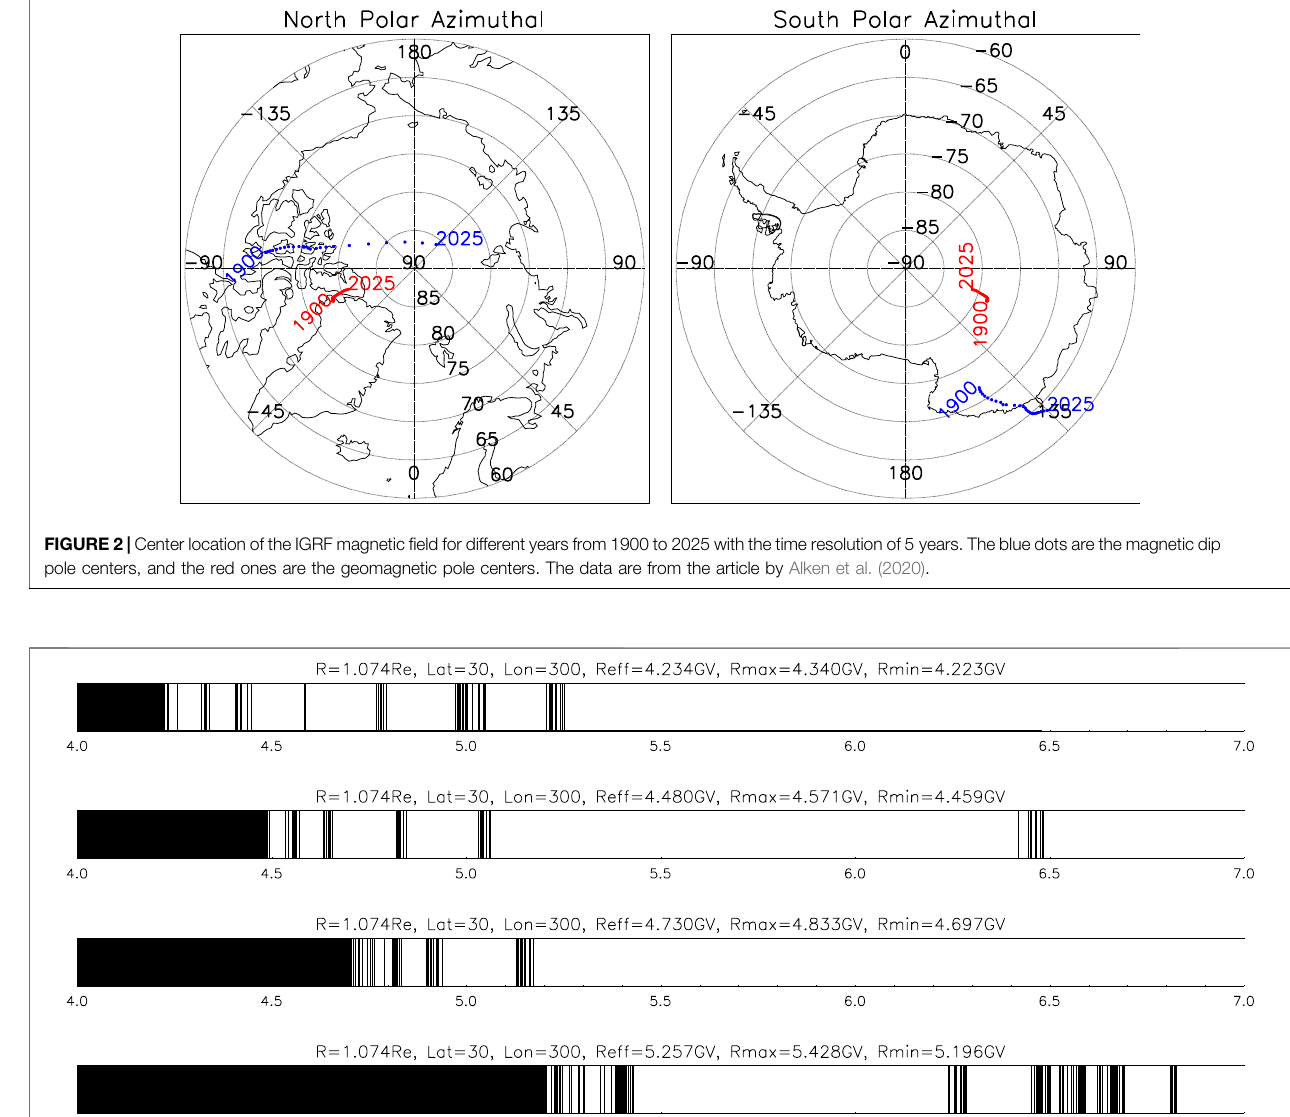
FIGURE 3| Illustration ofthe geomagnetic cutoff rigidities penumbra. This fi gure shows the maximum, minimum, and effectivecutoff rigidity at an interval of 1 MeV for the calculation of the rigidity at an altitude of 450 km, determined by trajectory calculations. In this illustration, black indicates forbidden rigidities, and white indicates allowed rigidities. Note that the cutoff is not sharp and that as the rigidity is decreased.The transmission ofcosmic rays changes from fully allowed at rigiditiesabove the maximum computed cutoff, R max , to partly allowed in the cosmic ray penumbra, to totally forbidden at rigidities below the minimum computed cutoff, R min . In addition,theyareeitherallowedorforbiddentoaccesswithrigiditiesbetween R max and R min ,soitisnamedthepenumbraarea.Thepanelfromtoptobottomrepresents the changes of the penumbra of the cutoff rigidities at the same location in 1965, 1985, 2005, and 2025, respectively.